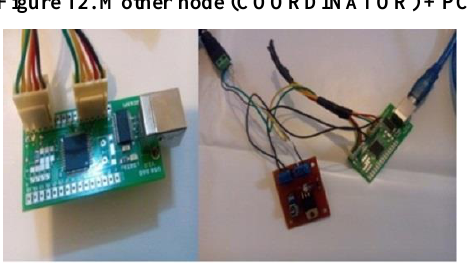
Figure 12. Mother node (COORDINATOR) + PC.